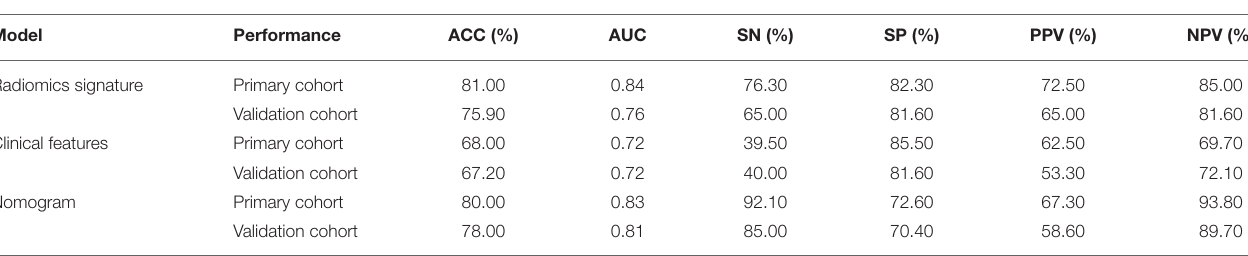
TABLE 4 | Performance of radiomics signature, clinical features and radiomic